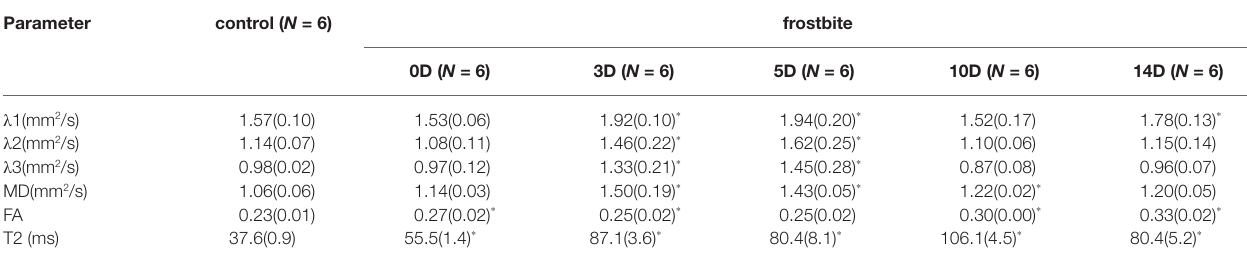
TABLE 4 | Mean diffusion tensor parameters and T2 values in frostbite and control.